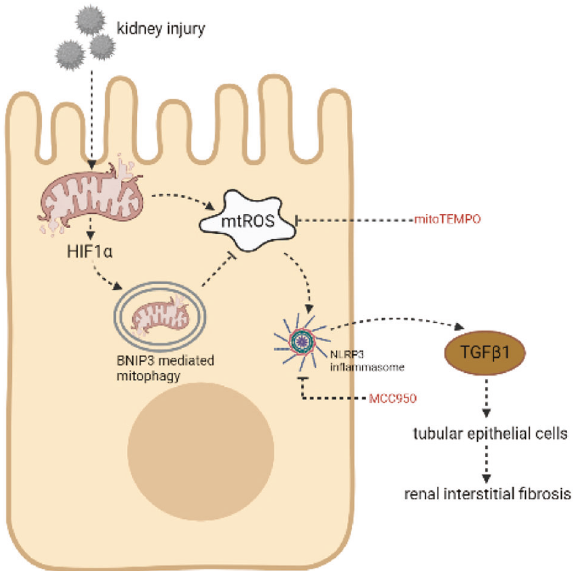
Fig. 8 Proposed mechanism for HIF1 α -BNIP3-mediated mito- phagy in alleviating renal fi brosis in UUO. Following UUO, a huge amount of ROS was released from damaged mitochondria, leading to increased expression of TGF β 1. BNIP3 de fi ciency enhanced the NLRP3 in fl ammasome activation and aggravated renal fi brosis in vivo and in vitro. Both inhibition of NLRP3 in fl ammasome and clearing ROS could protect the kidney against fi brosis, indicating the protective role of HIF1 α -BNIP3-mediated mitophagy in UUO by eliminating ROS and then inhibiting activation of the NLRP3 in fl